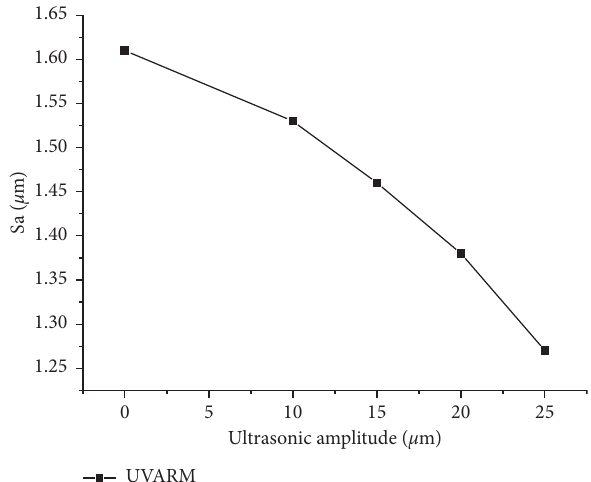
Figure 25: Surface roughness behavior with ultrasonic amplitude.